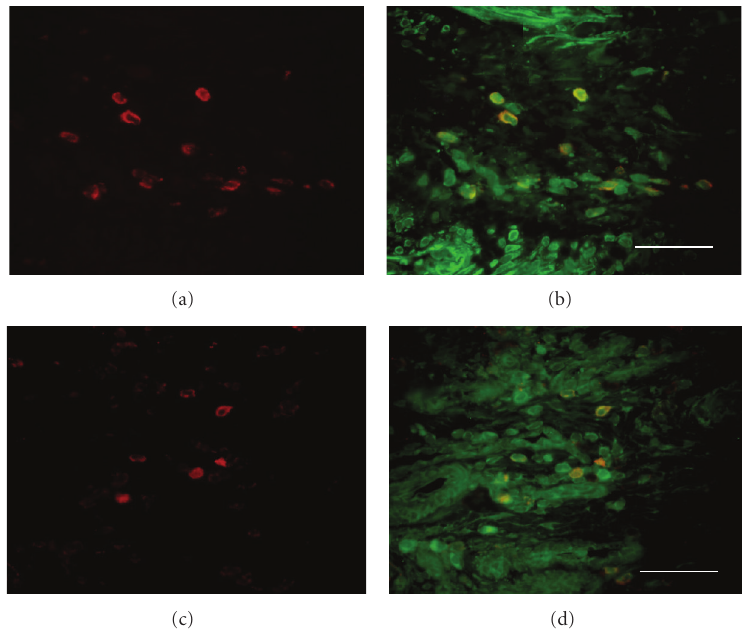
Figure 5: Expression of bradykinin B1 (a), (b) and B2 (c), (d) receptors on macrophages in human allergic nasal mucosa. (a) Macrophages (CD68-positive cells) (red). (b) Overlay image of bradykinin B1 receptor protein (green) and macrophages (CD68-positive) (red). The combined signal is visualized as yellow; (c) macrophages (CD68-positive) (red); (d) Overlay image of bradykinin B2 receptor protein (green); macrophages (CD68-positive cells) (red). Scale bar = 50 μ m.